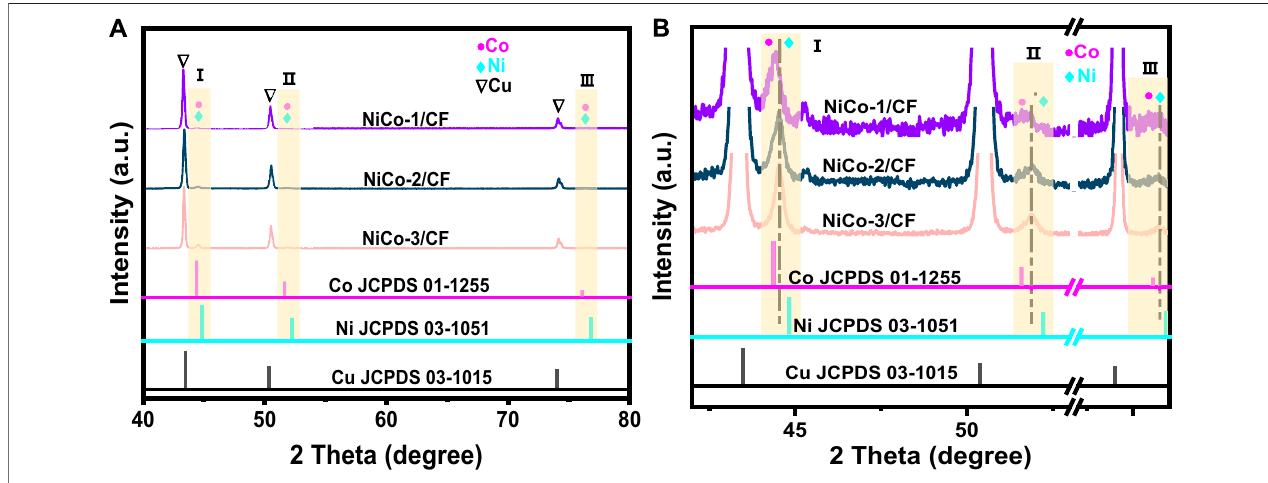
FIGURE 2 | XRD patterns (A) and magni fi ed XRD patterns (B) of NiCo-1/CF, NiCo-1/CF, and NiCo-1/CF.